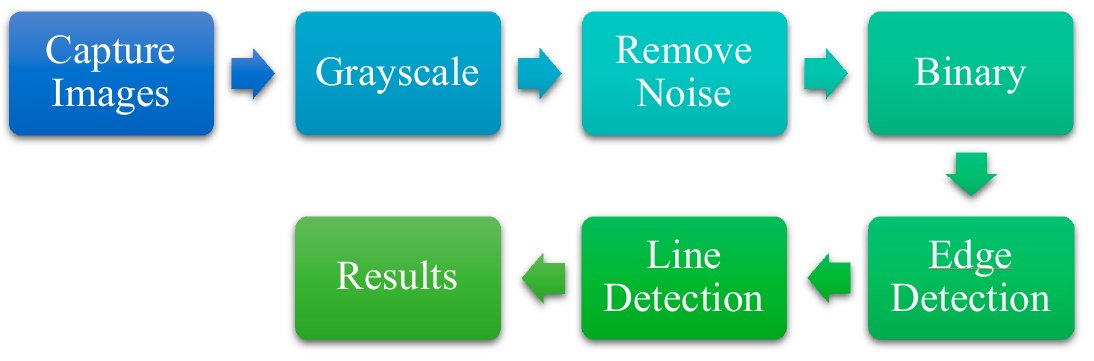
Figure 8. Flow chart of image processing.